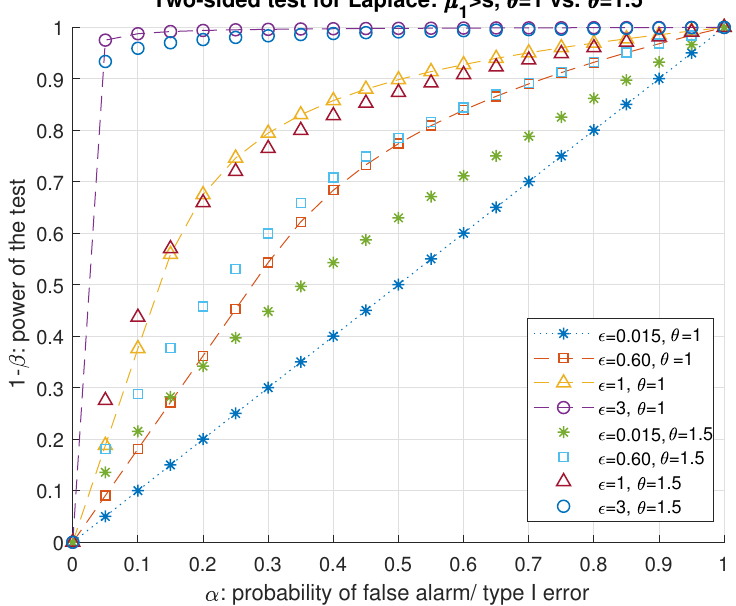
Figure 3. ROC curves for the two-sided hypothesis test ( ∆ µ = µ 1 > 0): (39) vs. (42) depicted for different values of privacy parameter, s < ∆ µ and θ = 1 vs. θ = 1.5.